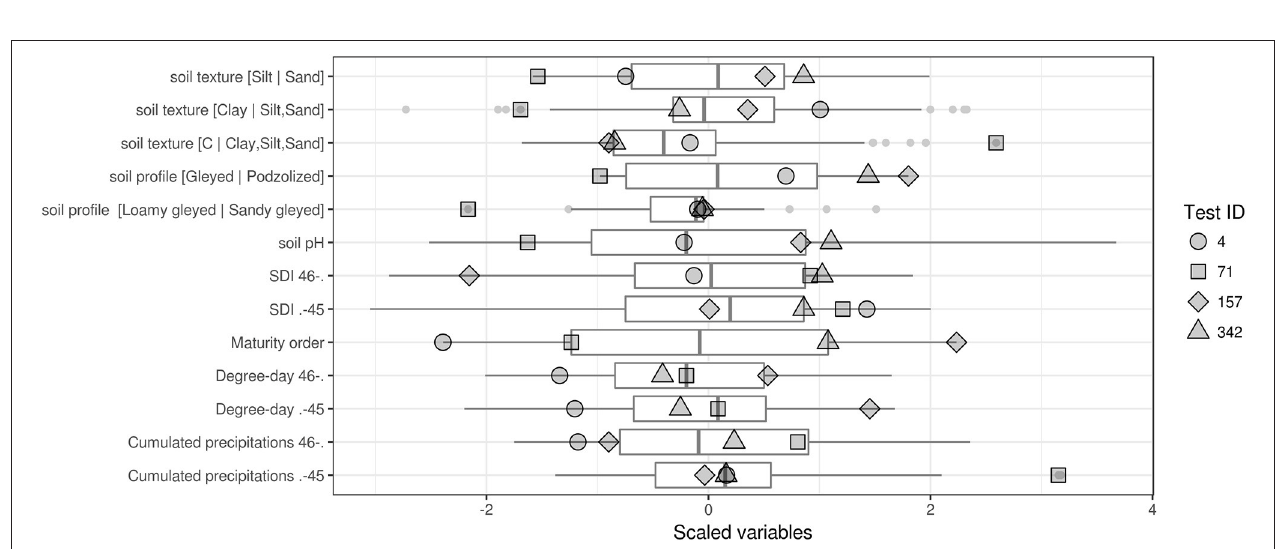
FIGURE 7 | Boxplots of scaled numerical variables to evaluate the N-model.